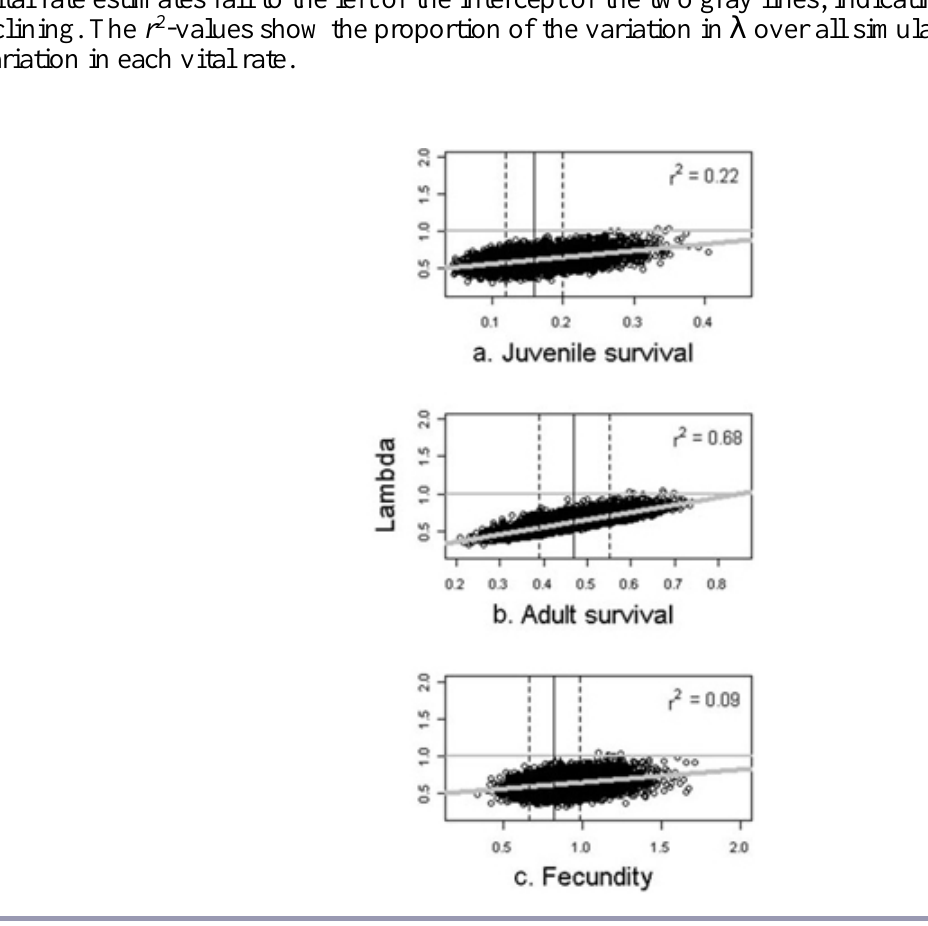
Fig. 2 . Results of a LSA for Streaked Horned Larks in western Washington, USA, using beta distributions to model adult and juvenile survival and a stretched beta distribution for fecundity. Light gray diagonal lines are regression lines. Horizontal gray lines are shown at l = 1. The value at the intercept of the two lines gives the parameter value needed to support a stable population. Vertical solid and dashed lines show the estimated mean value for each vital rate and its standard errors. In all cases, the vital rate estimates fall to the left of the intercept of the two gray lines, indicating that the population is declining. The r 2 -values show the proportion of the variation in l over all simulations that is explained by variation in each vital